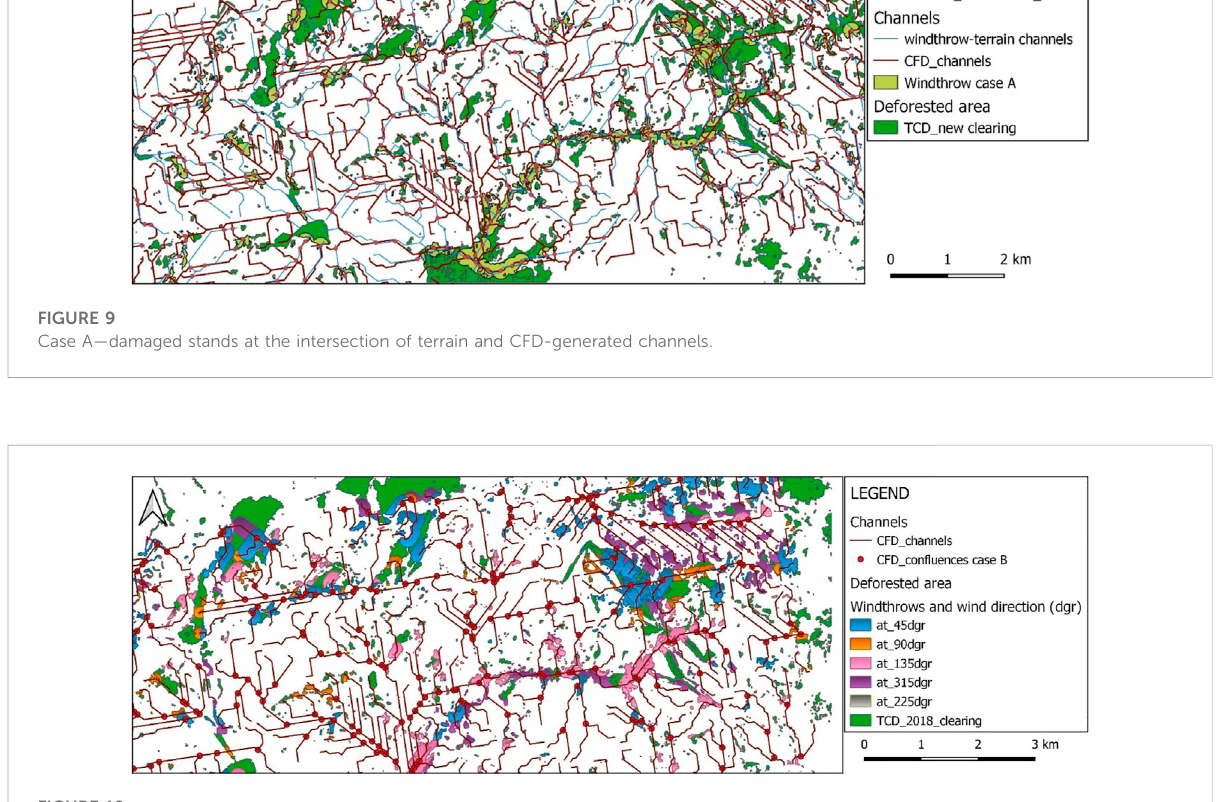
FIGURE 10 Case B — wind direction changes and CFD channel con fl uences and windthrows at different wind